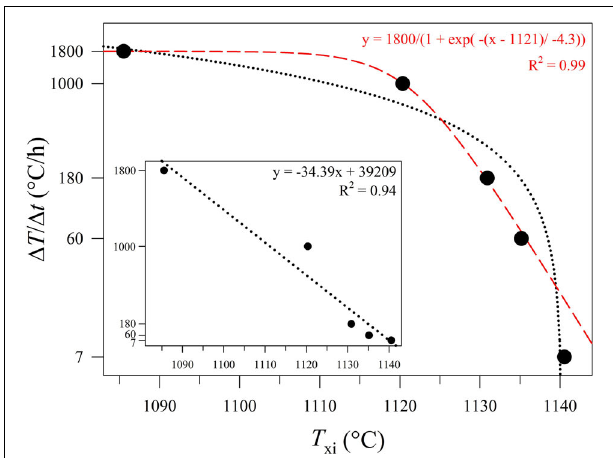
FIGURE 9 | T xi versus (cid:49) T / (cid:49) t ( ◦ C/h) according to data reported in Table 1 , Figures 1 , and Supplementary Figures S1A–E . As the cooling rate increase, the onset temperature of crystal nucleation decreases. The dotted black line refers to a linear regression fit. The dashed red line refers to an exponential regression fit.